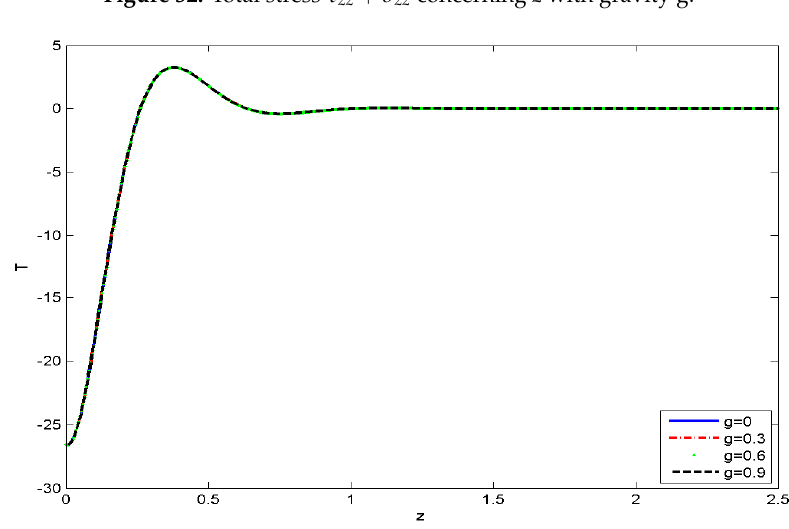
Figure 33. Temperature T concerning z with gravity g.